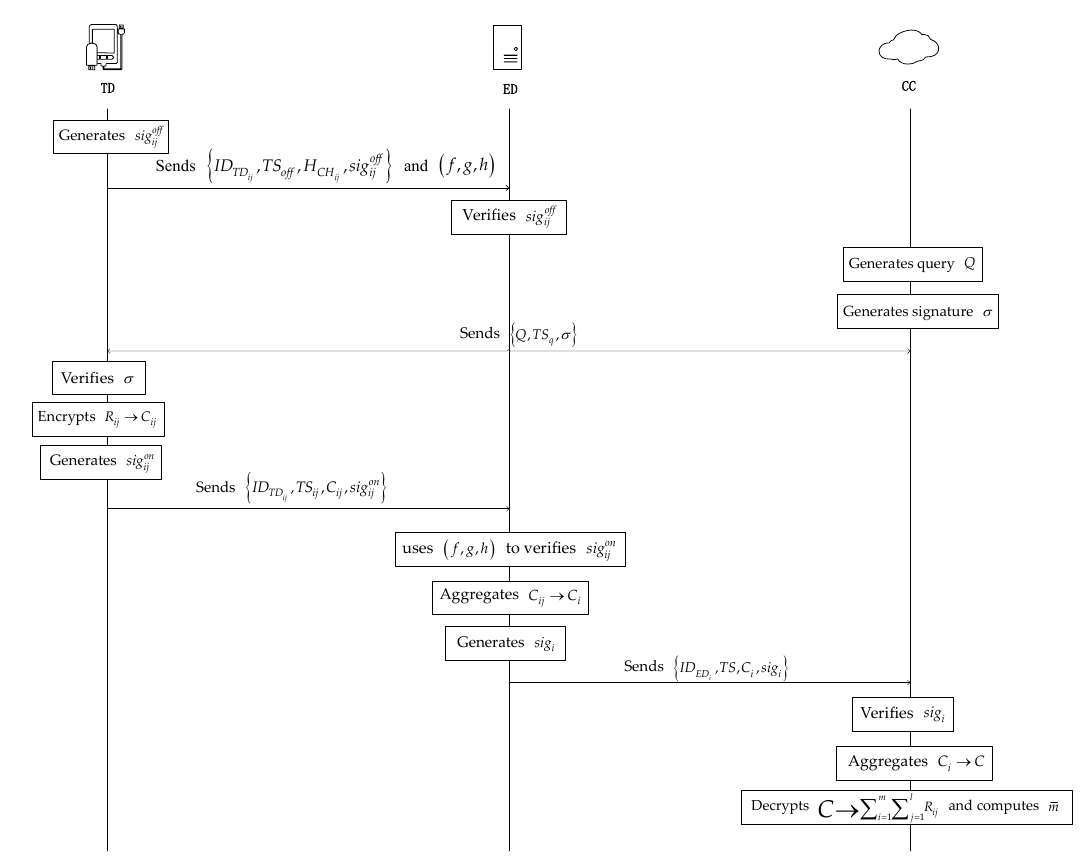
Figure 2. High-level description of the main phase of the PLSA-FT scheme. We also show the main phases of our proposed PLSA-FA scheme in Table 1. Table 1. The proposed PLSA-FA